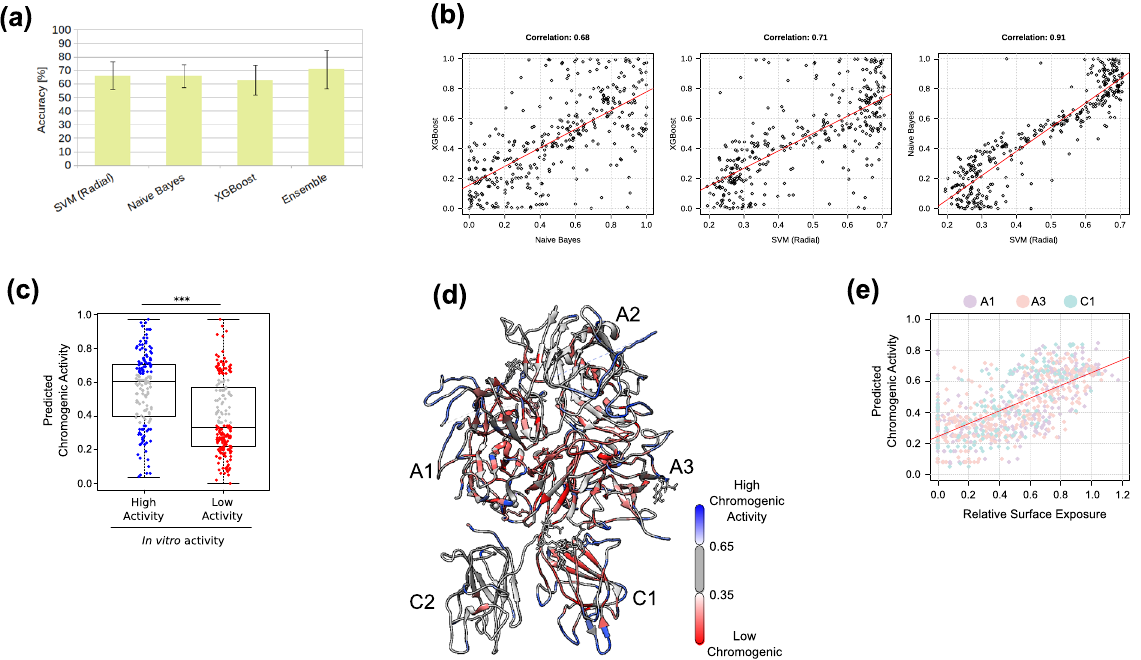
Figure 3. Machine learning framework and predictions. ( a ) The accuracy of both individual classifiers as well as the ensemble was calculated based on its correct classification of alanine mutations on the A2 and the C2 domains, using a 10 cross-fold validation (“Methods”). The variation in the accuracy values is due to the relatively small input (344 instances). The bars depict mean values and error bars, the standard deviation. ( b ) The predicted chromogenic activity outputted by the classifiers were only moderately correlated (Pearson’s correlation coefficient, p-value < 0.01). ( c ) In general, the FVIII mutant constructs with chromogenic activity similar to the wild-type form received high scores from the classifier ensemble. Likewise, low-activity mutants correctly received low scores. The boxplots depict the median (center line), the first and third quartiles (lower- and upper-bounds), and 1.5 times the inter-quartile range (lower- and upper whiskers). Each dot in the plot is an amino acid mutation (i.e., an in vitro alanine mutant construct). Unpaired, two-sided Wilcoxon test (***Indicate p-values < 0.001). ( d ) Predicted chromogenic activity mapped into the FVIII structure (Supplementary Table S2 lists all predicted values). ( e ) The relation between the predicted chromogenic